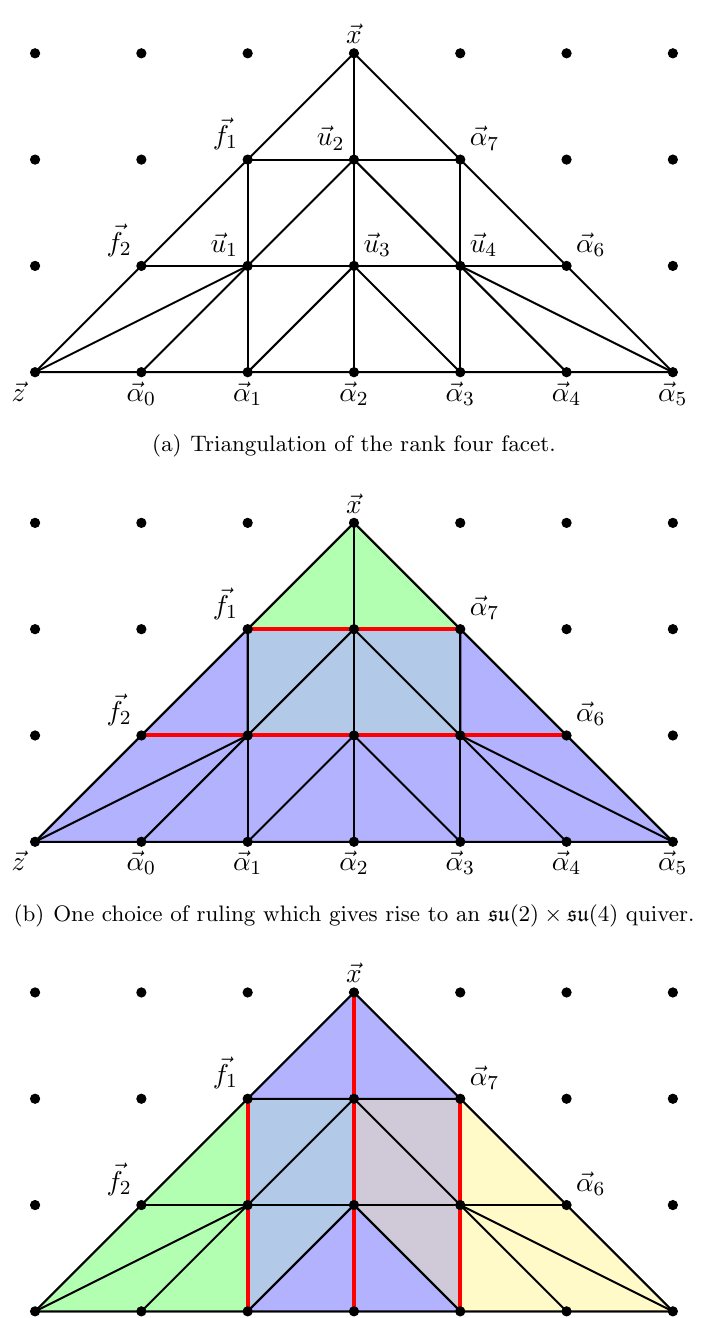
Figure 9 . In this triangulation, the surface f u ~z (cid:0) ~ f 2 , that of f u 2 g by ~x (cid:0) ~(cid:11) 7 (cid:0) ~u 4 (cid:0) ~u 3 (cid:0) ~u 1 (cid:0) ~ f 1 , that of f u 3 g by ~u 2 (cid:0) ~u 4 (cid:0) ~(cid:11) 3 (cid:0) ~(cid:11) 3 (cid:0) ~(cid:11) 1 (cid:0) ~u 1 , and that of f u 4 g by ~(cid:11) 7 (cid:0) ~(cid:11) 6 (cid:0) ~(cid:11) 5 (cid:0) ~(cid:11) 4 (cid:0) ~(cid:11) 3 (cid:0) ~u 3 (cid:0) ~u 2 . Depending on the rulings, along which